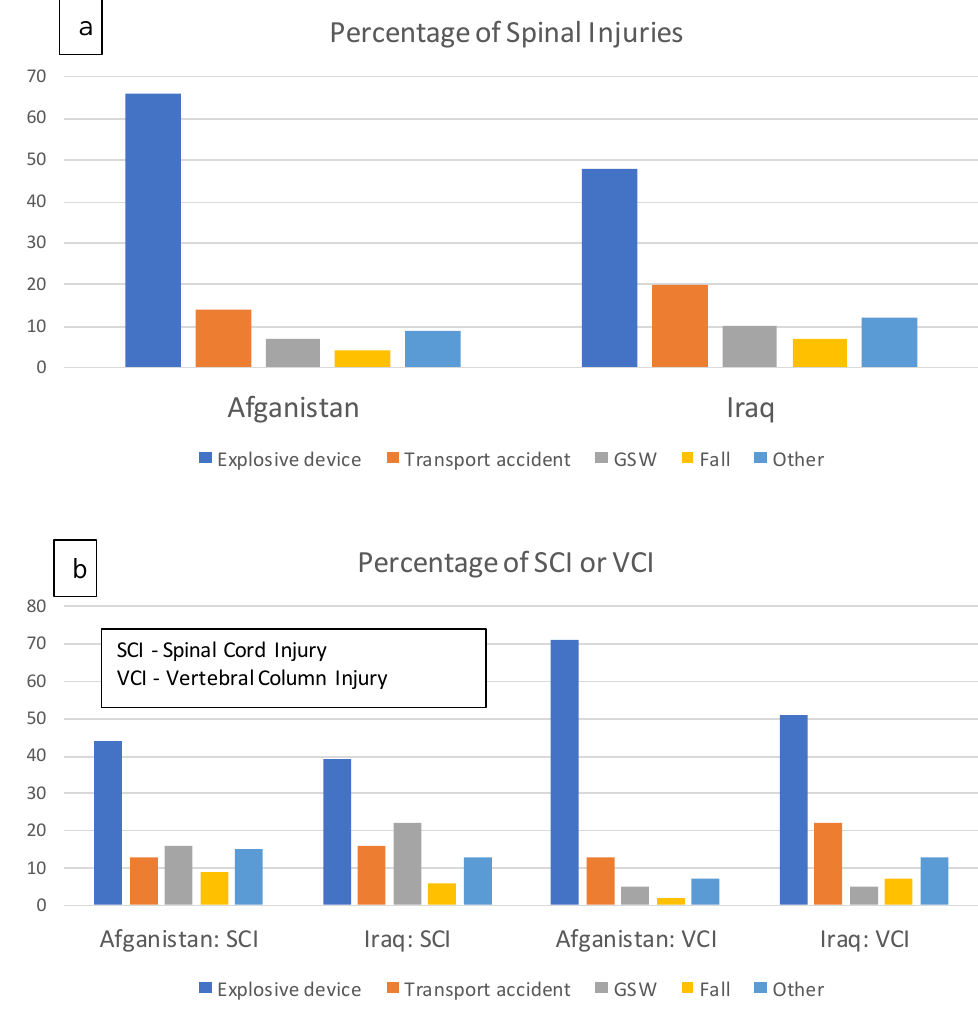
Figure 3. Causes and types of spinal injuries of soldiers participating in missions in Iraq and Afghanistan: percentage of spinal injuries – a, percentage of SCI or VCI injuries – b. Own study based on [22].